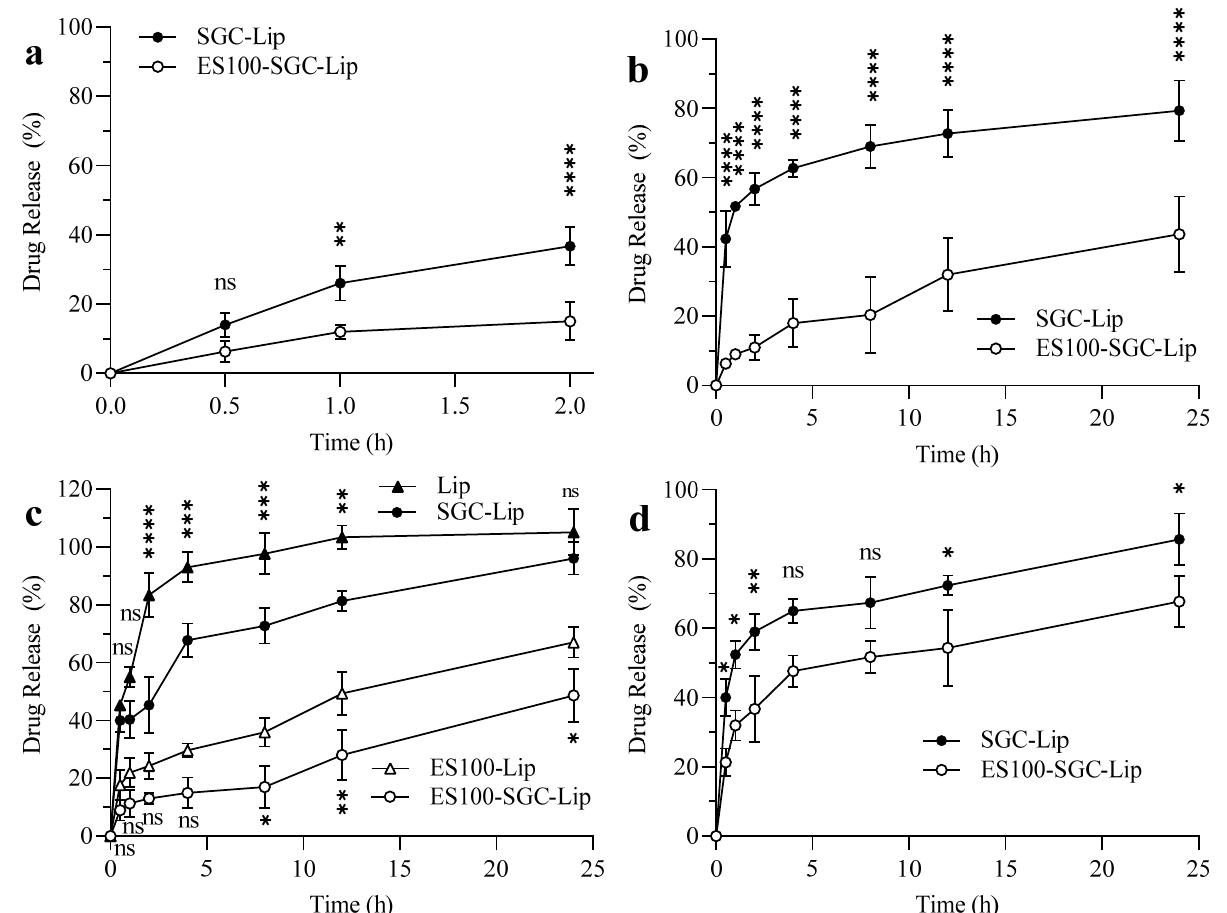
Figure 5. In vitro drug release of different liposomal formulations: SGC-Lip and ES100-SGC-Lip in ( a ) SGF (pH = 1.2), ( b ) FaSSIF (pH = 6.5), ( c ) FeSSIF (pH = 5), and ( d ) PBS (pH = 7.4). Notes: The data represent the mean ± standard deviation (n = 3). Two-way ANOVA followed by Tukey test were used for statistical analysis and comparison. In ( c ), two additional formulations, Lip and ES100-Lip, were also tested in FeSSIF. In ( a , b , d ), Tukey test was conducted to compare SGC-Lip with ES100-SGC-Lip formulations, except for ( c ) where Tukey test was conducted to compare Lip with SGC-Lip and ES100-Lip with ES100-SGC-Lip formulation. n = 3. (ns p ≥ 0.05, * p < 0.05, ** p < 0.005, *** p < 0.001, **** p <